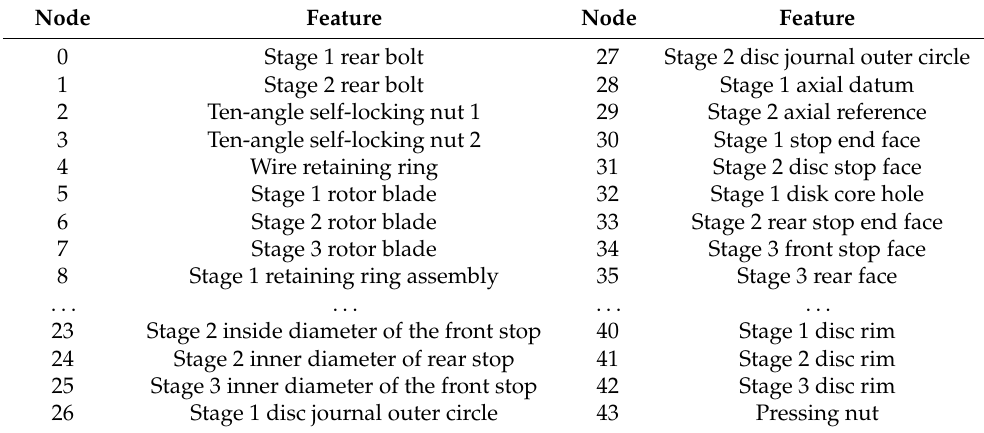
Figure 8. The assembly process of the fan rotor. Table 1. Correspondence between node naming and representative part